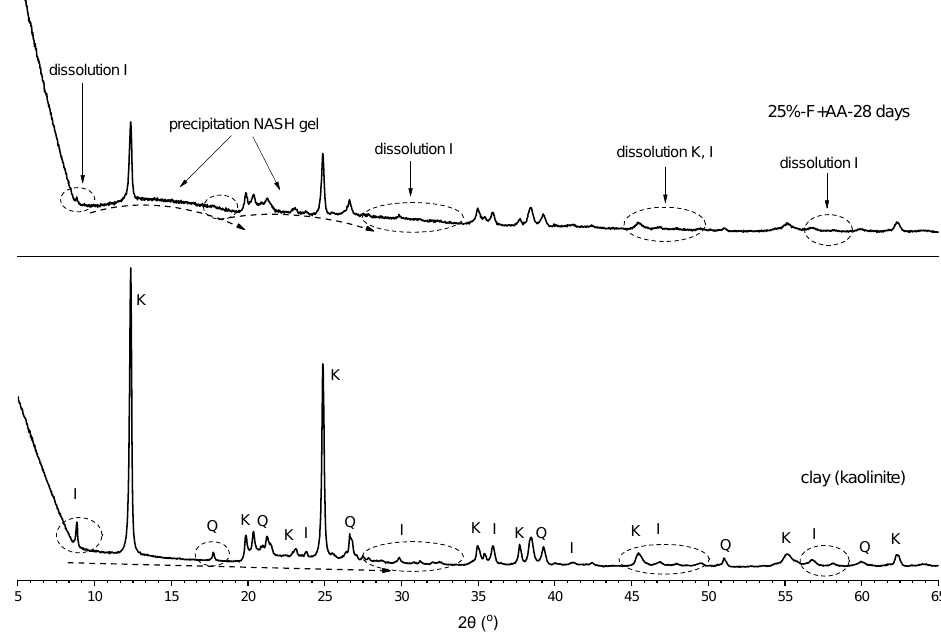
Figure 13. XRD patterns of clay and soil stabilised with 25% of alkali-activated fly ash at 28 days of curing; I = illite, K = kaolinite, Q = quartz.